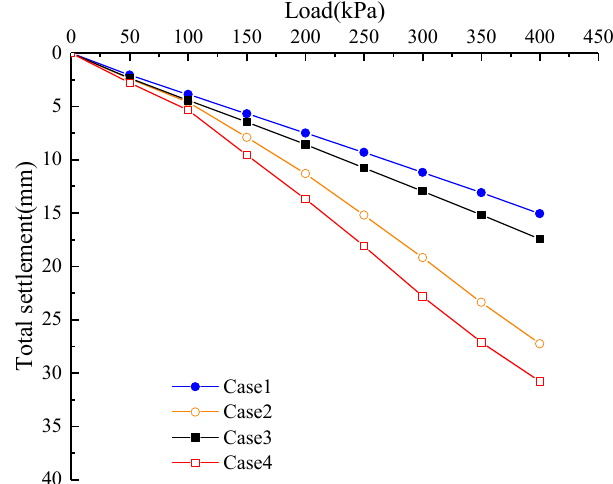
Figure 14. Load–total settlement curve.